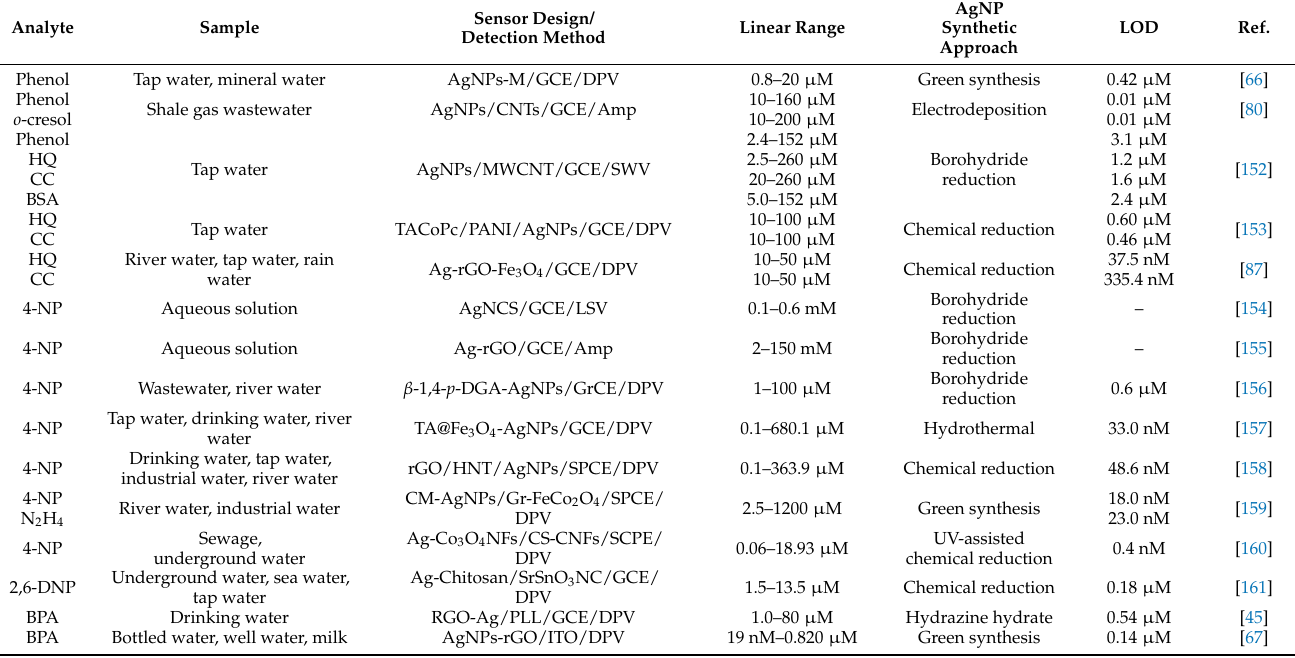
Table 3. Survey of the reviewed silver nanomaterial-based electrochemical sensors for detection of phenolic compounds in water